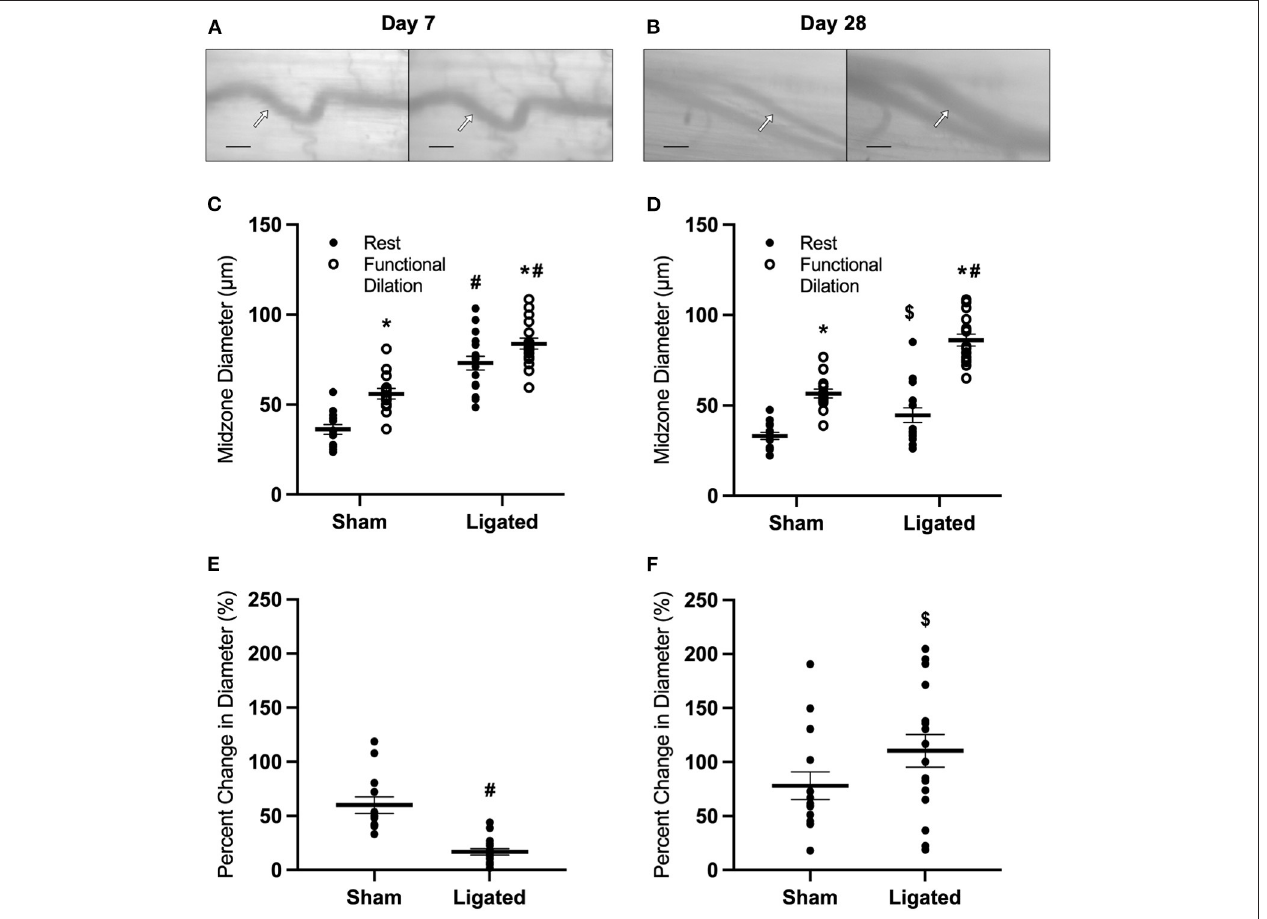
FIGURE 1 | Collateral functional vasodilation is impaired at day 7 and restored at day 28. Collateral vessels were observed at the collateral midzone by intravital microscopy with transillumination at 7 days (A) or 28 days (B) post-femoral artery ligation in the left mouse hindlimb at rest (left) and following functional vasodilation (right); arrow indicates the enlarged collateral arteriole and scale bar represents 100 µ m. At each time point, the gracilis muscles of C57Bl/6 mice ( n = 17, 9 male and 8 female, at day 7 and n = 16, 8 male and 8 female, at day 28) were stimulated with tungsten microelectrodes and a stimulus isolator. At day 7, both resting and maximum diameters were increased in the ligated limb compared to the sham (C) , and vascular reactivity was decreased (E) . At day 28, maximum diameters remained increased in the enlarged collateral in comparison to the native collateral, but resting diameter was smaller than at day 7 (D) . Vascular reactivity in the enlarged collateral at day 28 was greater than at day 7, and was no longer different from the native collateral (F) . * p < 0.05 vs. resting, # p < 0.05 vs. sham, $ p < 0.05 vs. day